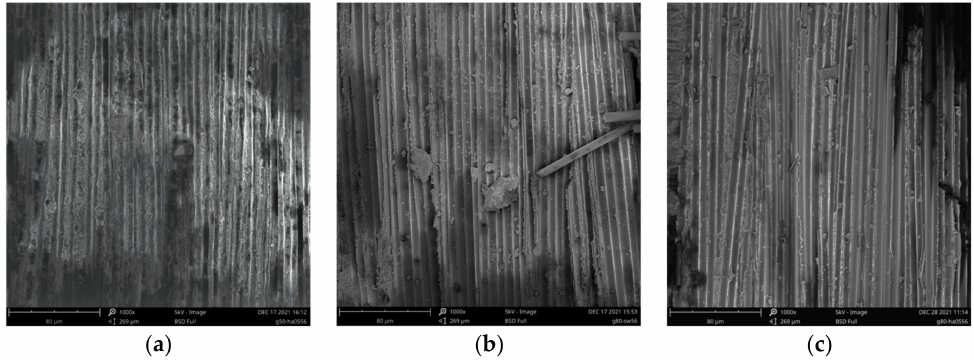
Figure 13. SEM images of the specimens’ strip surfaces. ( a ) 05HA-50-56, ( b ) SW-80-56, ( c )